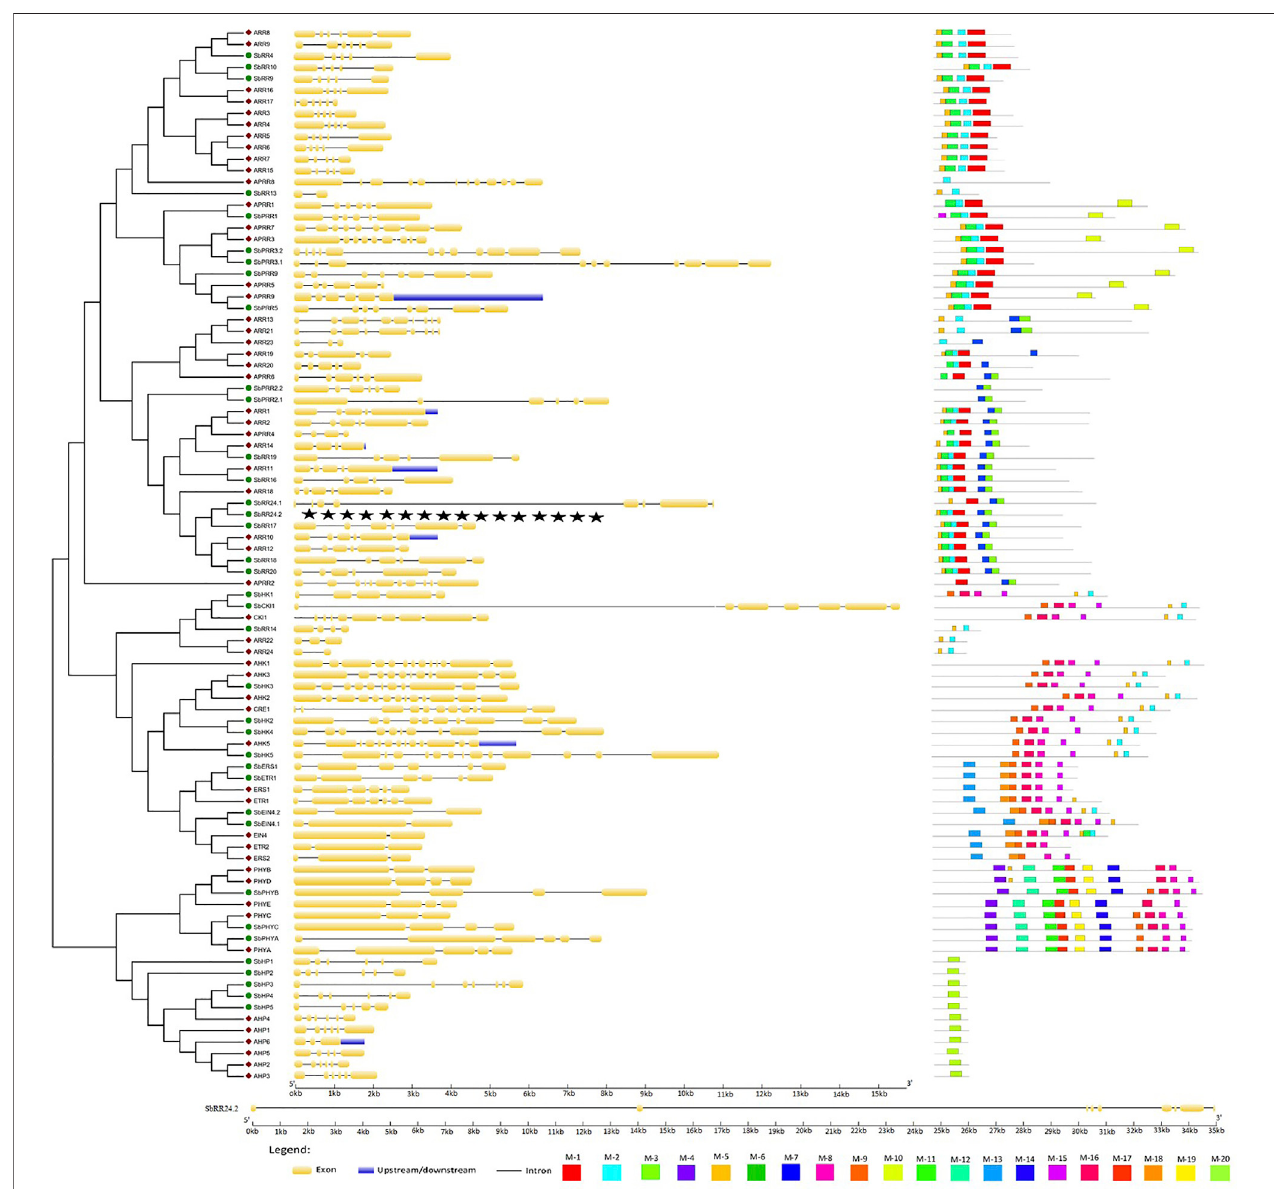
FIGURE3| Genestructure and conservedmotifs of allHK(L), HPand RR family genesin S. bicolor. In genestructure, theexons,introns, and untranslatedregions are indicated by yellow boxes, black lines and blue boxes, respectively. In conserved motifs, different color represents different motifs.